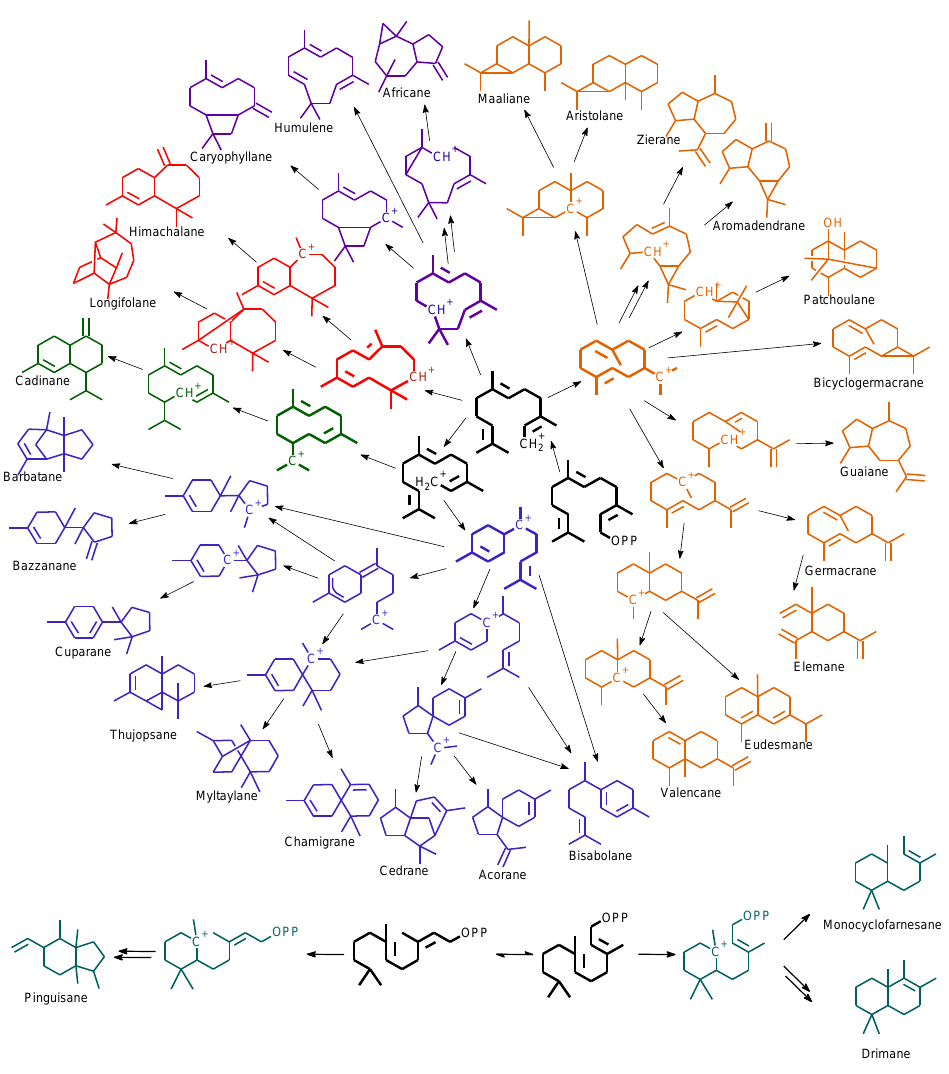
Figure 3. Overview of sesquiterpene types detected through the compiled biosynthesis schemes [9–18]